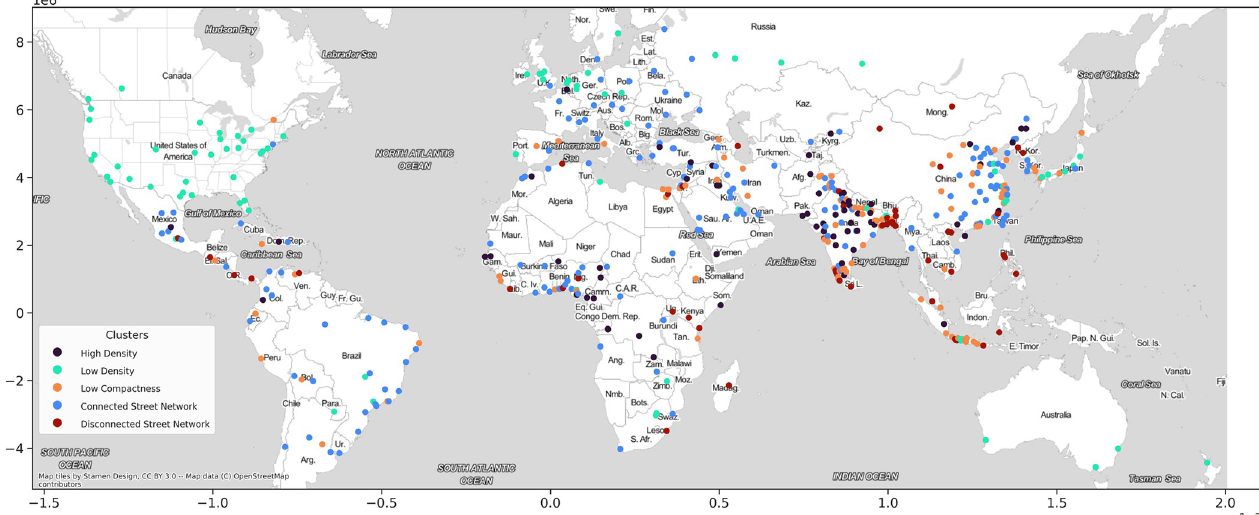
Fig 6. Typology of cities based on urban form metrics. Base map and data from OpenStreetMap and OpenStreetMap Foundation.